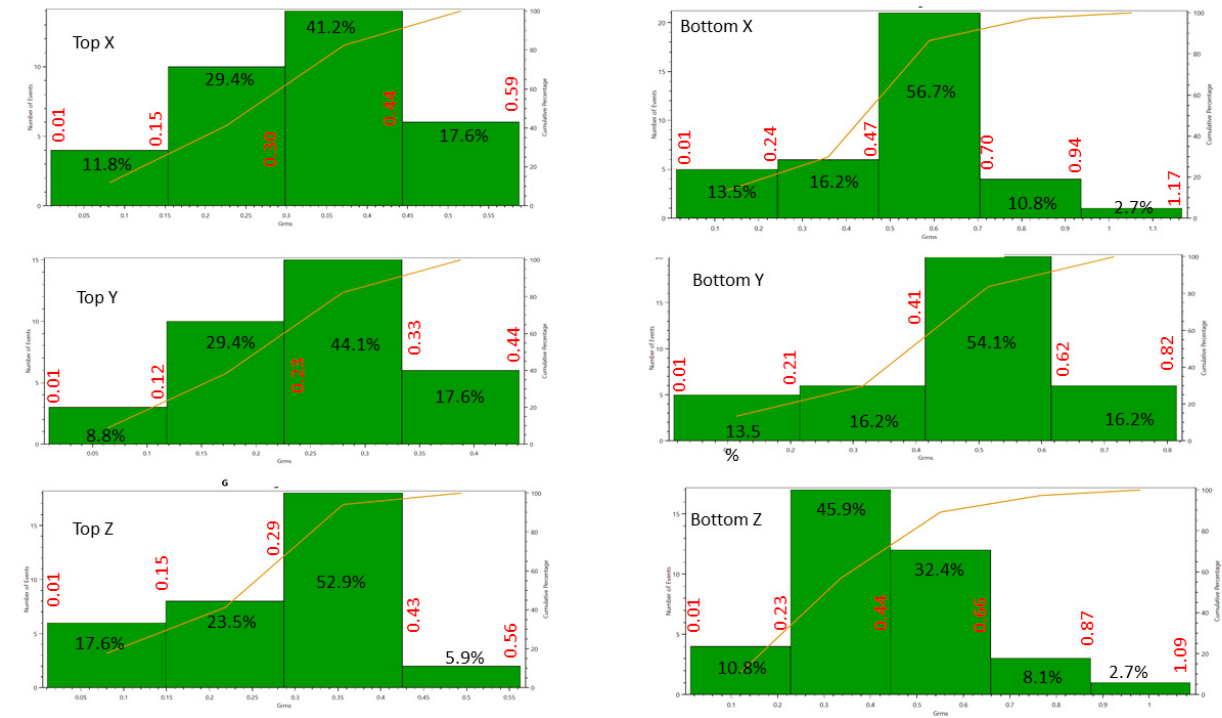
Figure 9. Vibration G rms histogram for DJI 100.